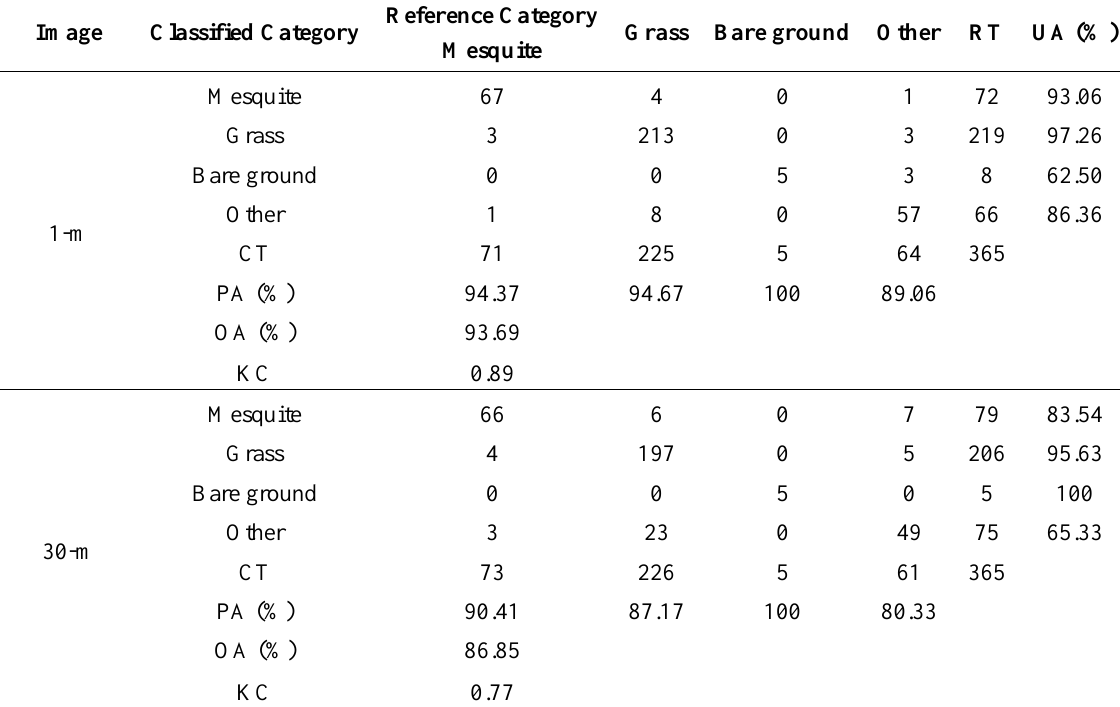
Table2. Error matrix for the 1 and 30-m image classifications generated from the reference and classified data using the 1 and 30-m images of the study site for mesquite, grass, bare ground, and other land cover